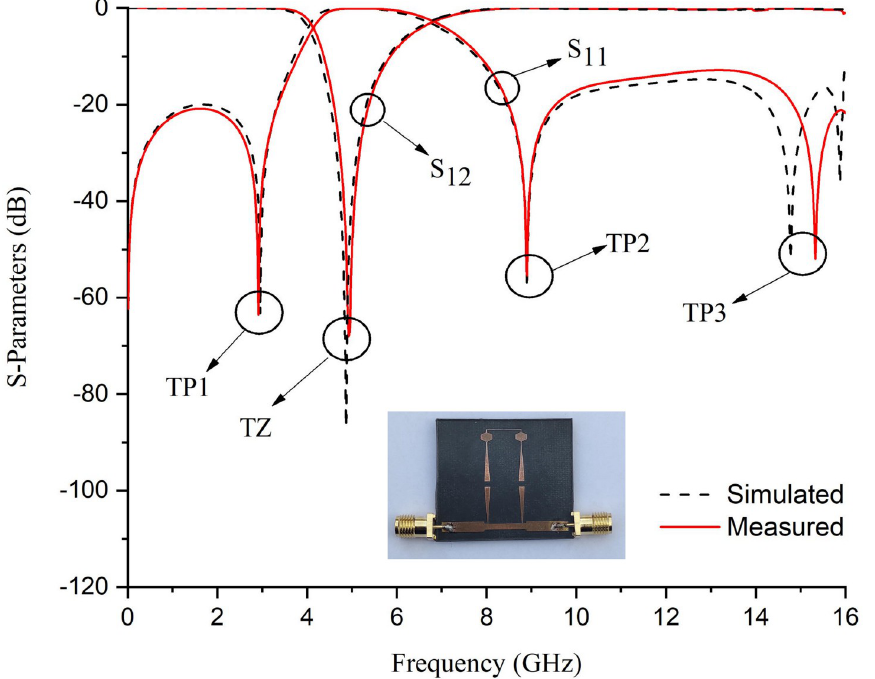
Fig 9. S-Parameter response of the fabricated single-order BSF.